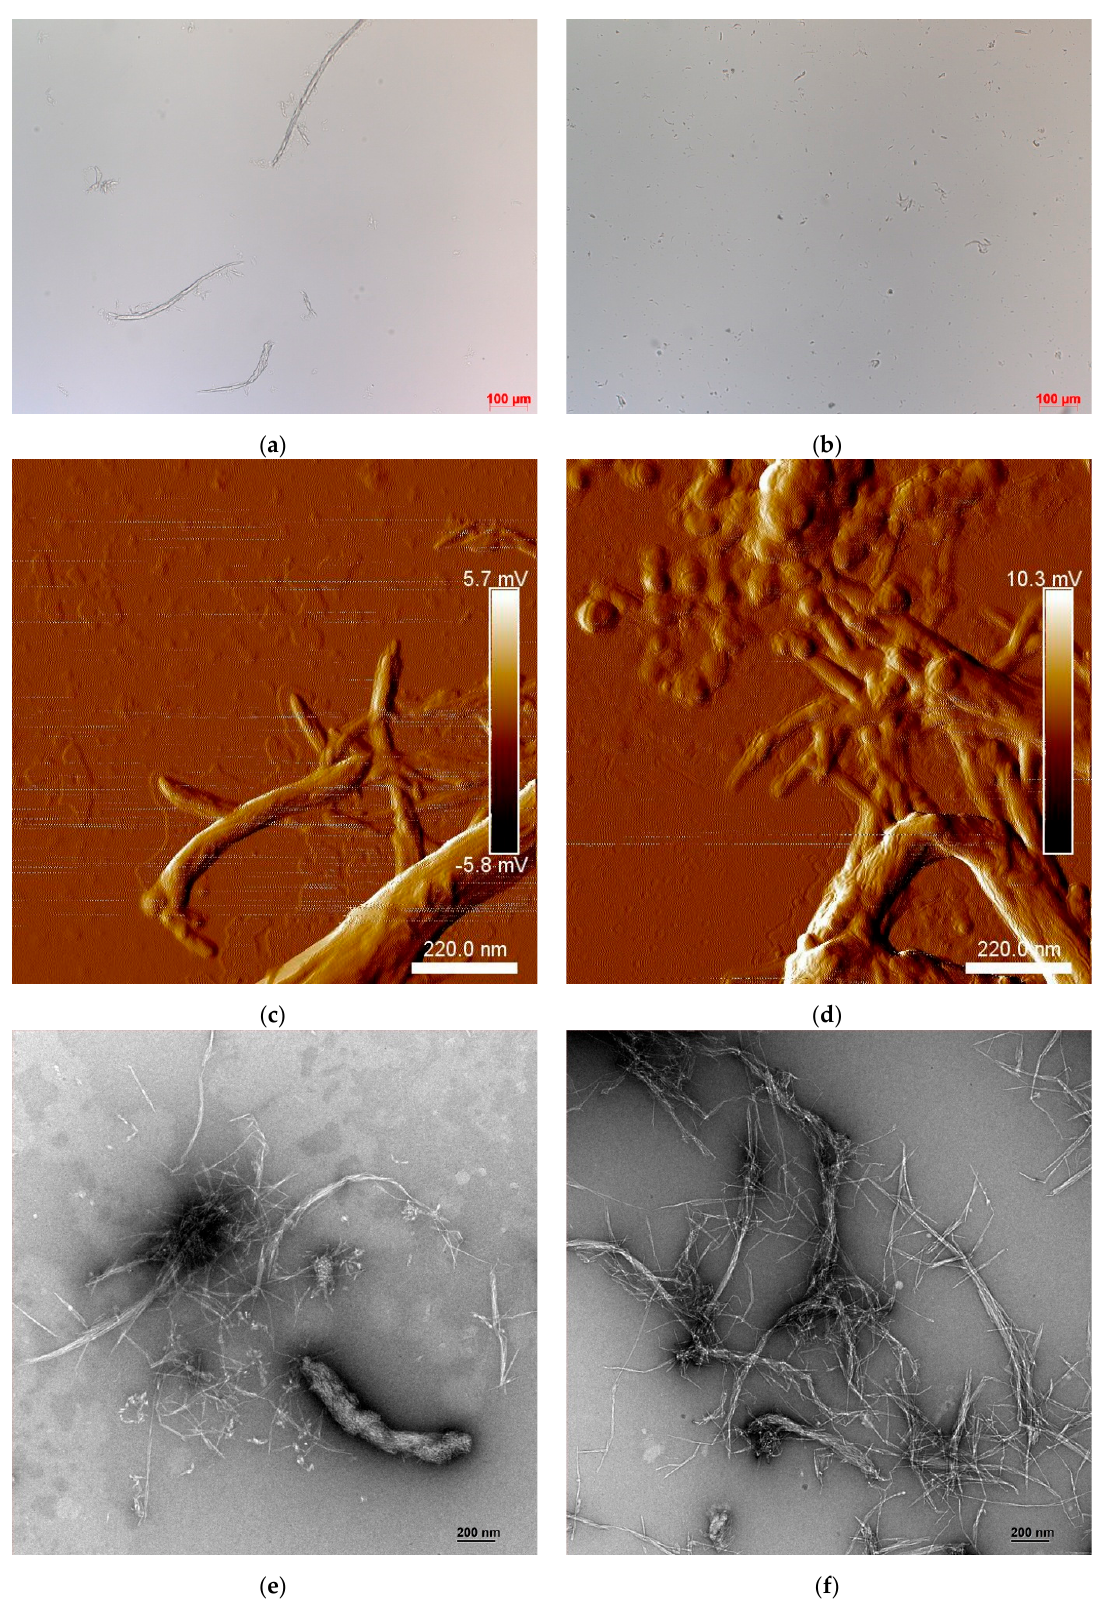
Figure 3. Optical observation of CNF–TSE ( a ) and CNF–M ( b ). AFM images of CNF–TSE ( c ) and CNF–M ( d ). TEM micrographs of CNF-TSE ( e ) and CNF–M ( f ).